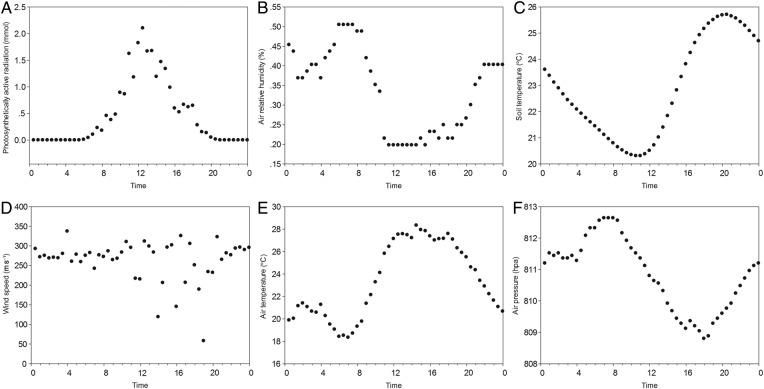
Diurnal variation in meteorological factors at the field experiment site on 25 June 2013. The diurnal change in (A) PAR (mmol), (B) AirRh (%), (C) SoilTm (°C), (D) wind speed (m s−1), (E) AirTm (°C) and (F) AirP (hPa).